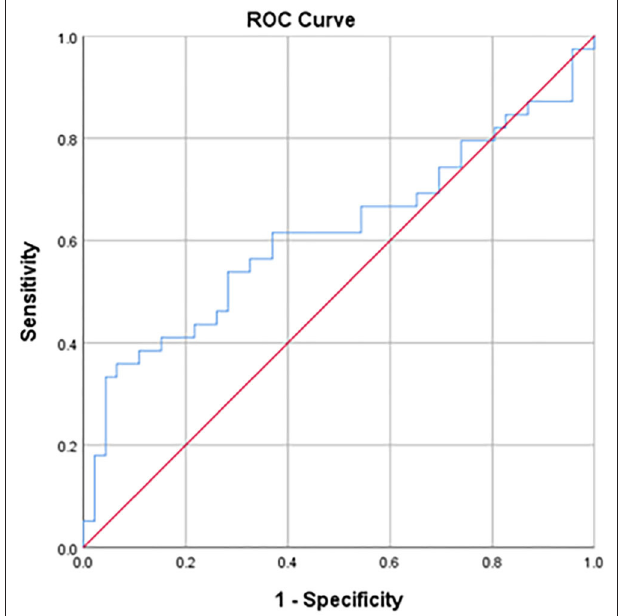
FIGURE 2 | Receiver operator curve of the PAQ-C score and its ability to predict the achievement of daily moderate-to-vigorous physical activity levels ( > 60min). The area under the curve is 0.62. The best performance was found with a PAQ-C cutoff of 3.09 (53.8% sensitivity and 71.7%